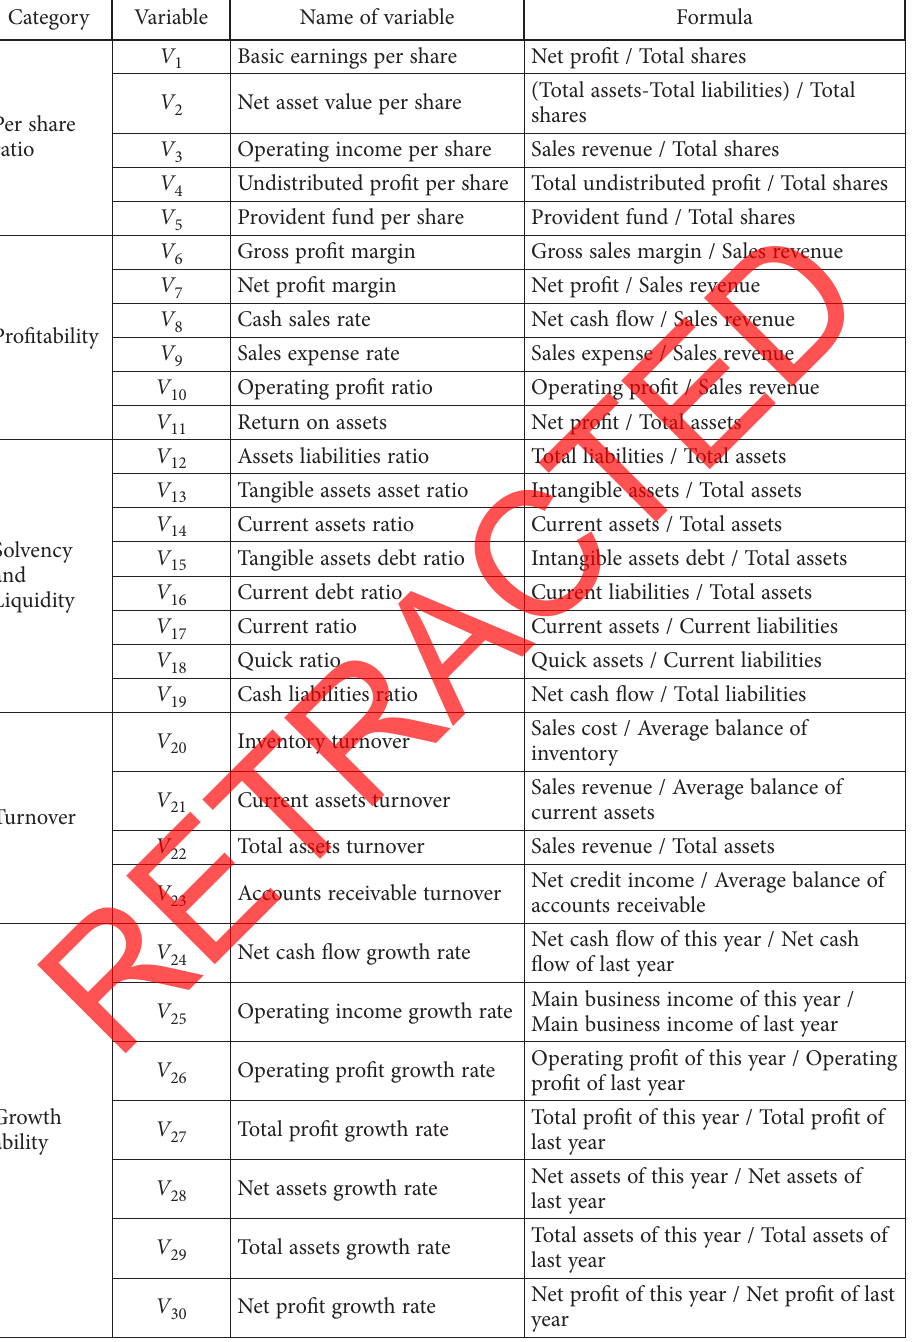
Table 3. Initial financial